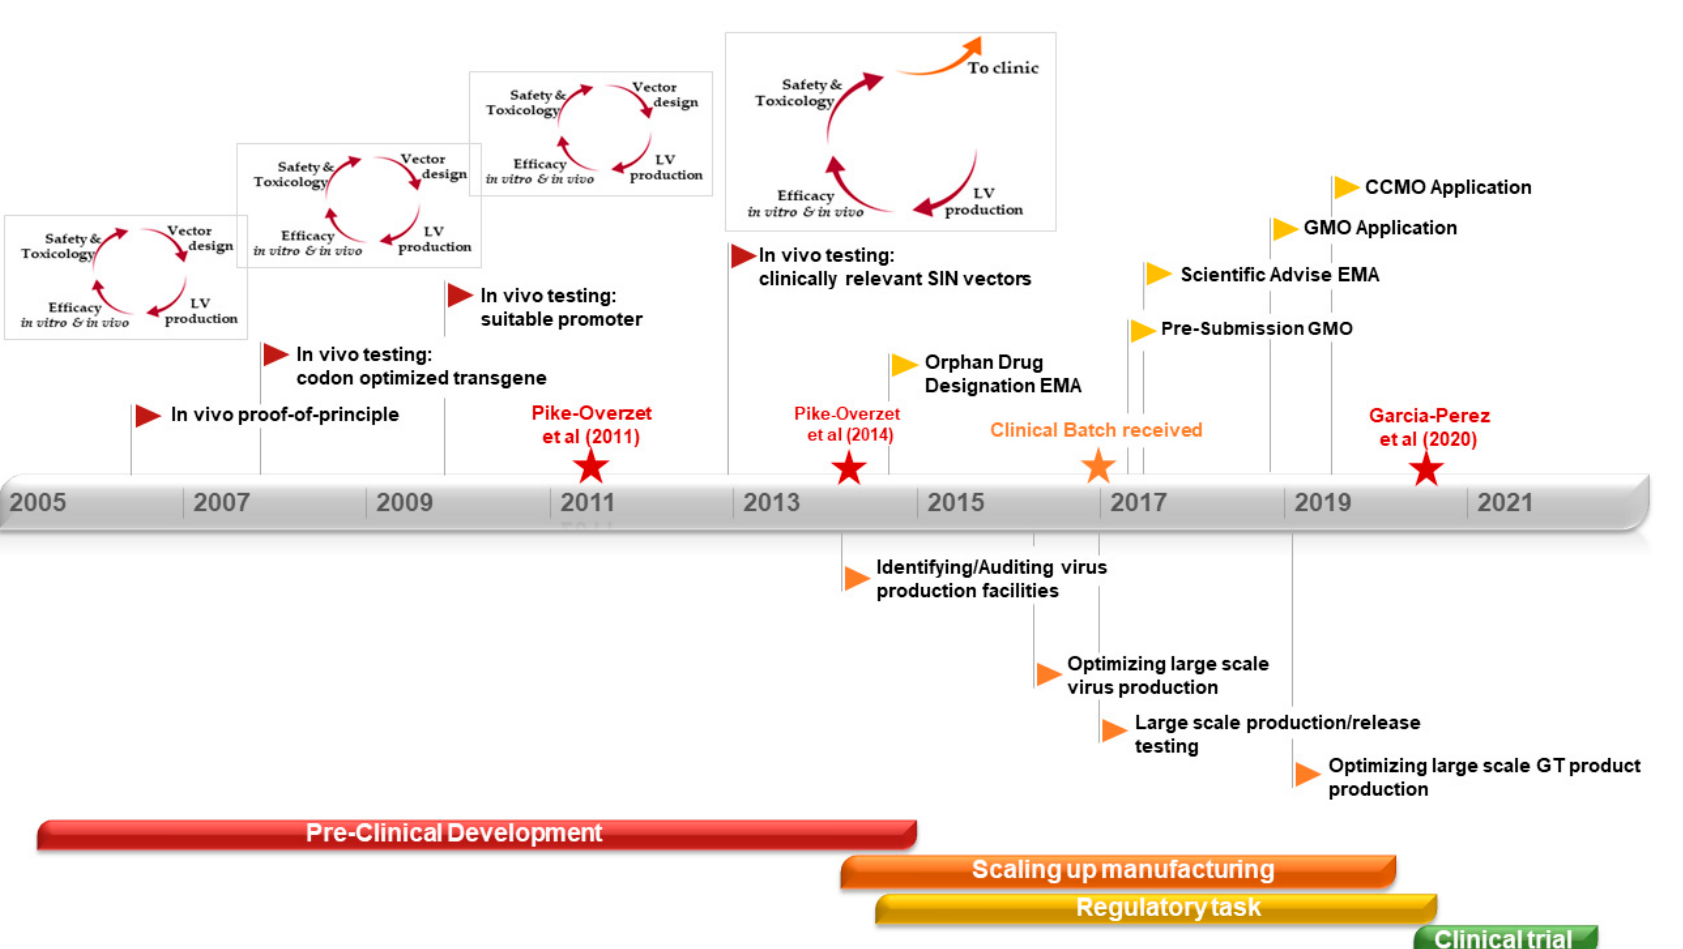
Figure 2. Development of autologous stem cell-based gene therapy for RAG1 severe combined immuodeficiency (SCID): A journey from mouse house to bed side. (Lentiviral Vector (LV); Centrale Commissie Mensgebonden Onderzoek (CCMO); European Medicines Agency (EMA); Genetically Modified Organism (GMO); Gene Therapy (GT)).